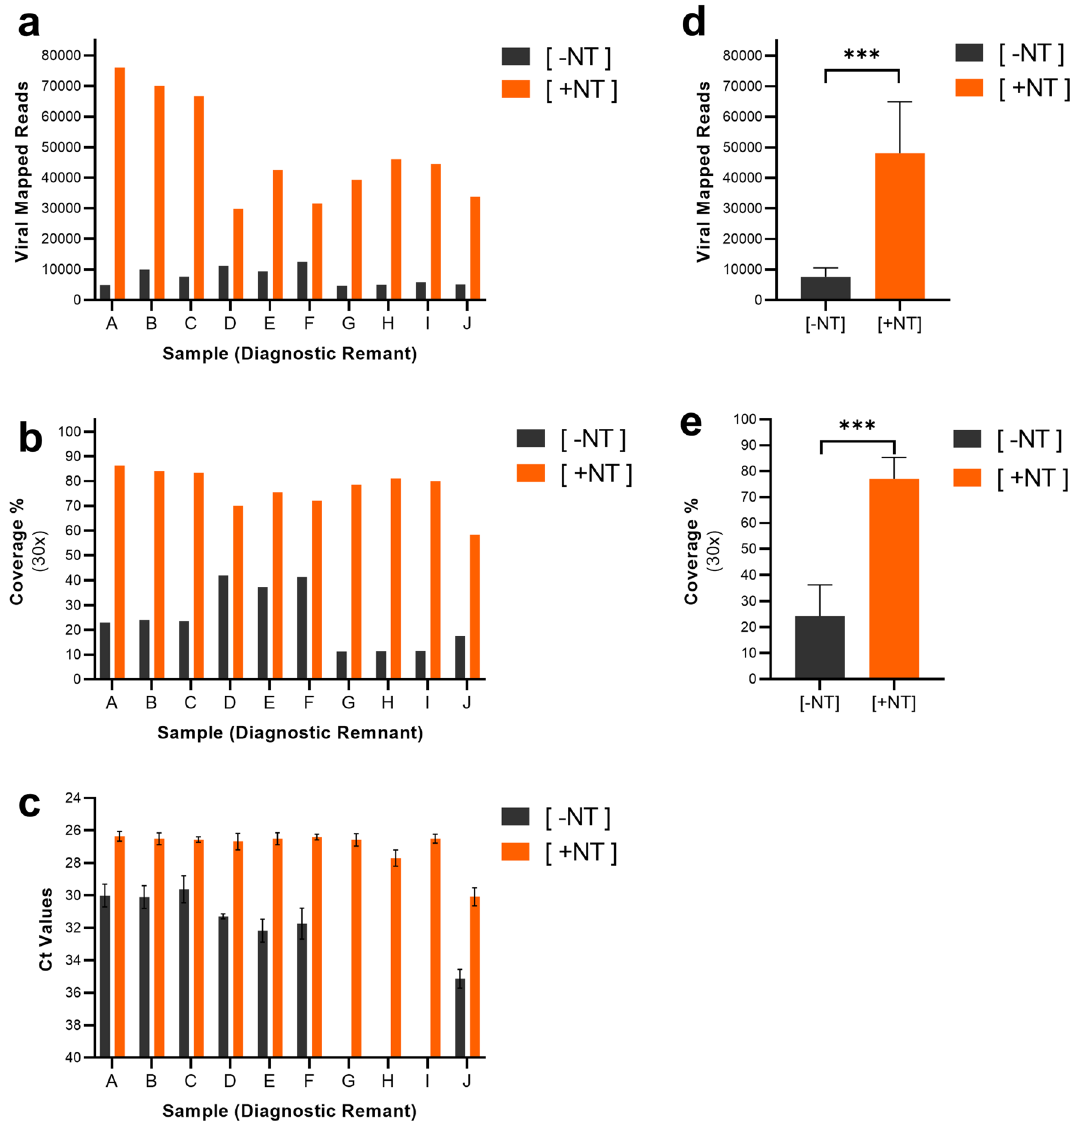
Figure 3. Magnetic Hydrogel Particles (Nanotrap Particle Workflow 1) Improves Sequencing of Diagnostic Remnant SARS-CoV-2 Samples. 10 SARS-CoV-2 positive diagnostic remnant samples were processed using Nanotrap Particle Workflow 1 [+ NT] or the RNEasy Kit alone [− NT]. Samples then underwent sequencing on a ONT MinION R.9 flow cell and were analyzed by Viral Mapped Reads to SARS-CoV-2 ( a ), Viral